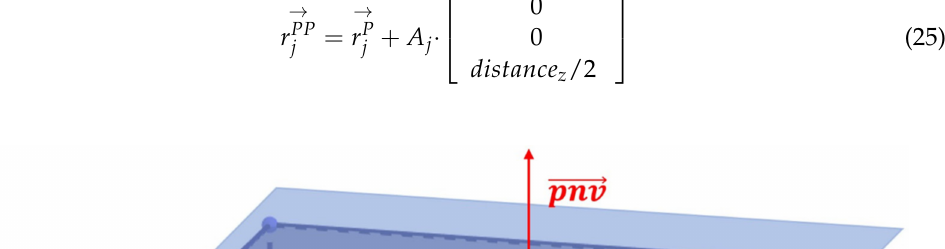
Figure 10. Location of point PP and vector